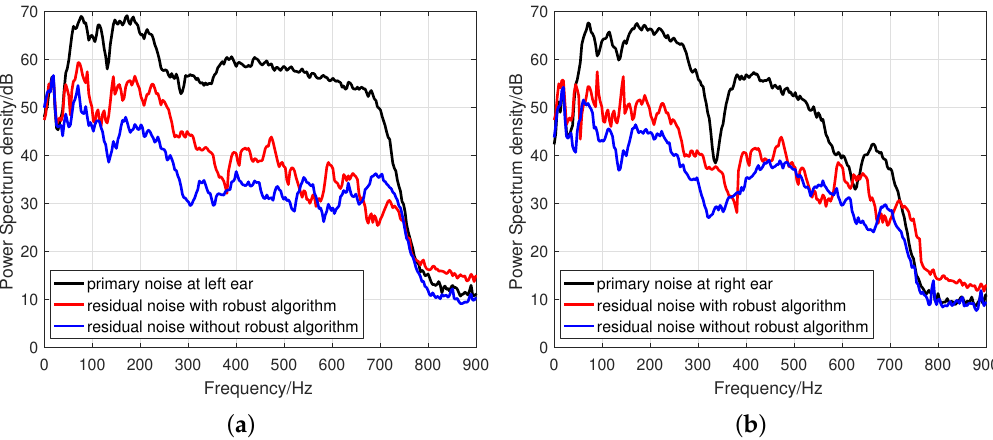
Figure 4. Noise control performance of the headrest at left and right ears with and without robust algorithm: ( a ) noise control performance at left ear when the head has no rotation; and ( b ) noise control performance at right ear when the head has no rotation.